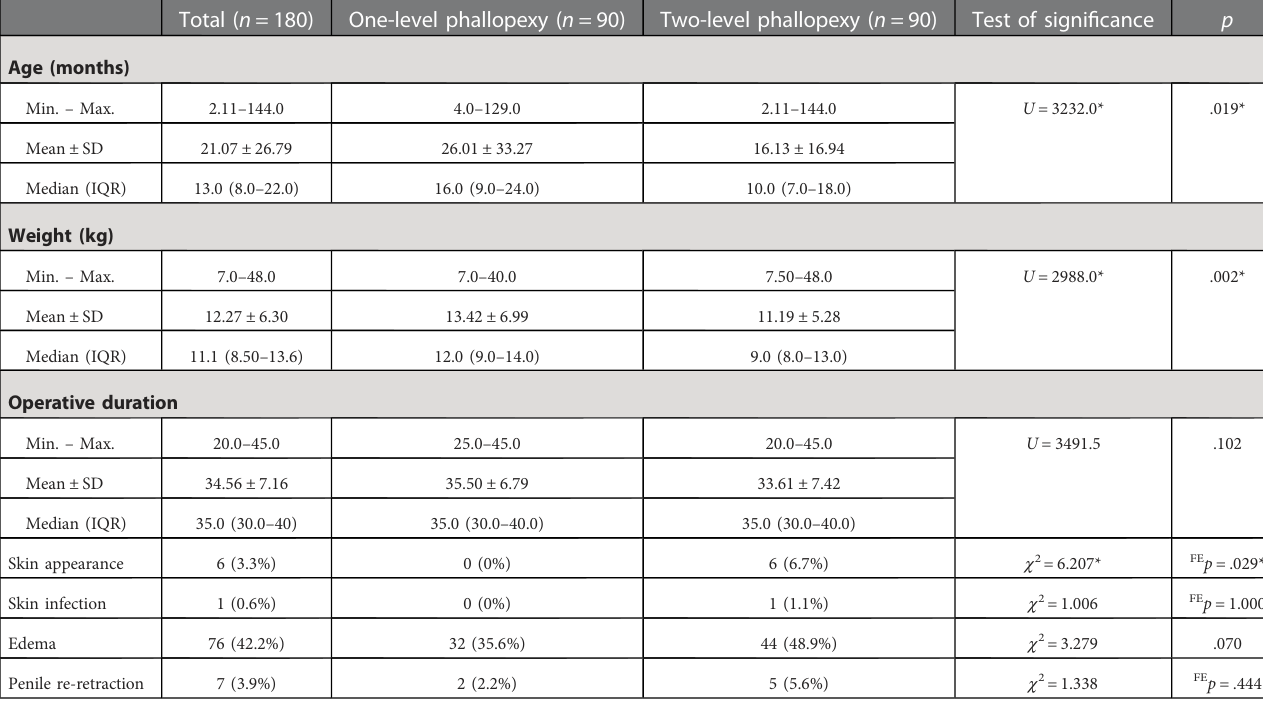
TABLE 1 Comparison between the two studied groups according to different parameters. Total ( n =